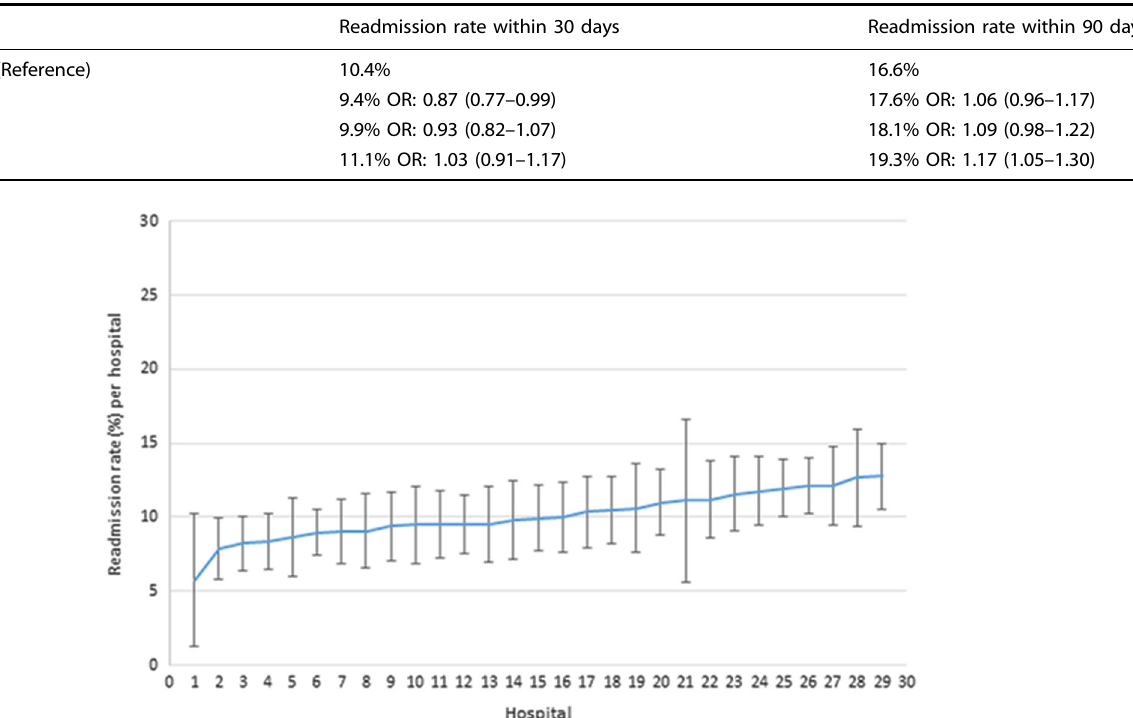
Table 2. Comparison of the risk (odds ratio ± 95% CI) of COPD readmission within 30 days and 90 days, dependent on the LOS of the index COPD admission. Multiple logistic regression adjusted for patient sex, age, and deprivation score